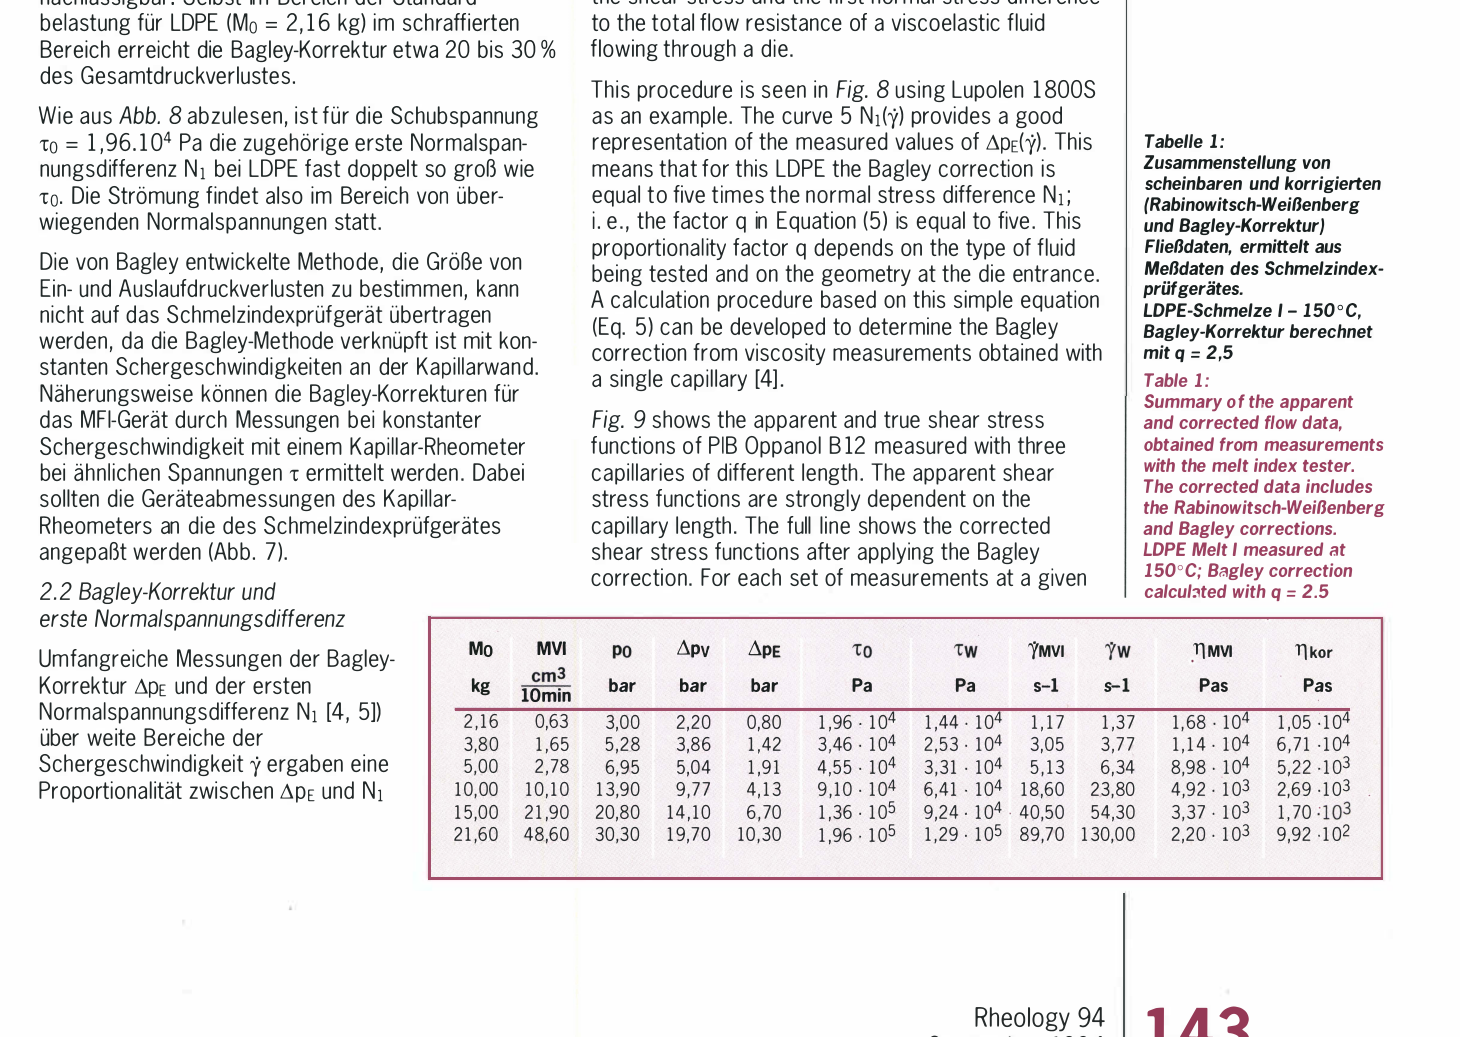
scheinbaren und korrigierten (Rabinowitsch-WeiBenberg und Bagley-Korrektur} Flie/Jdaten, ermittelt aus Me/Jdaten des Schmelzindex­ priifgerates.